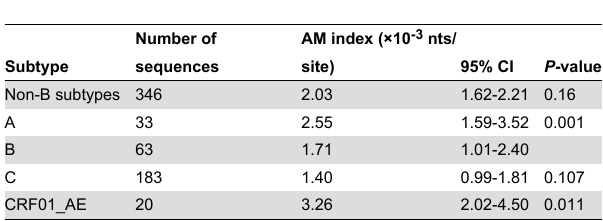
Table 3. Comparison of ambiguous mutation (AM) in the recent infections of subtype B and other subtypes.